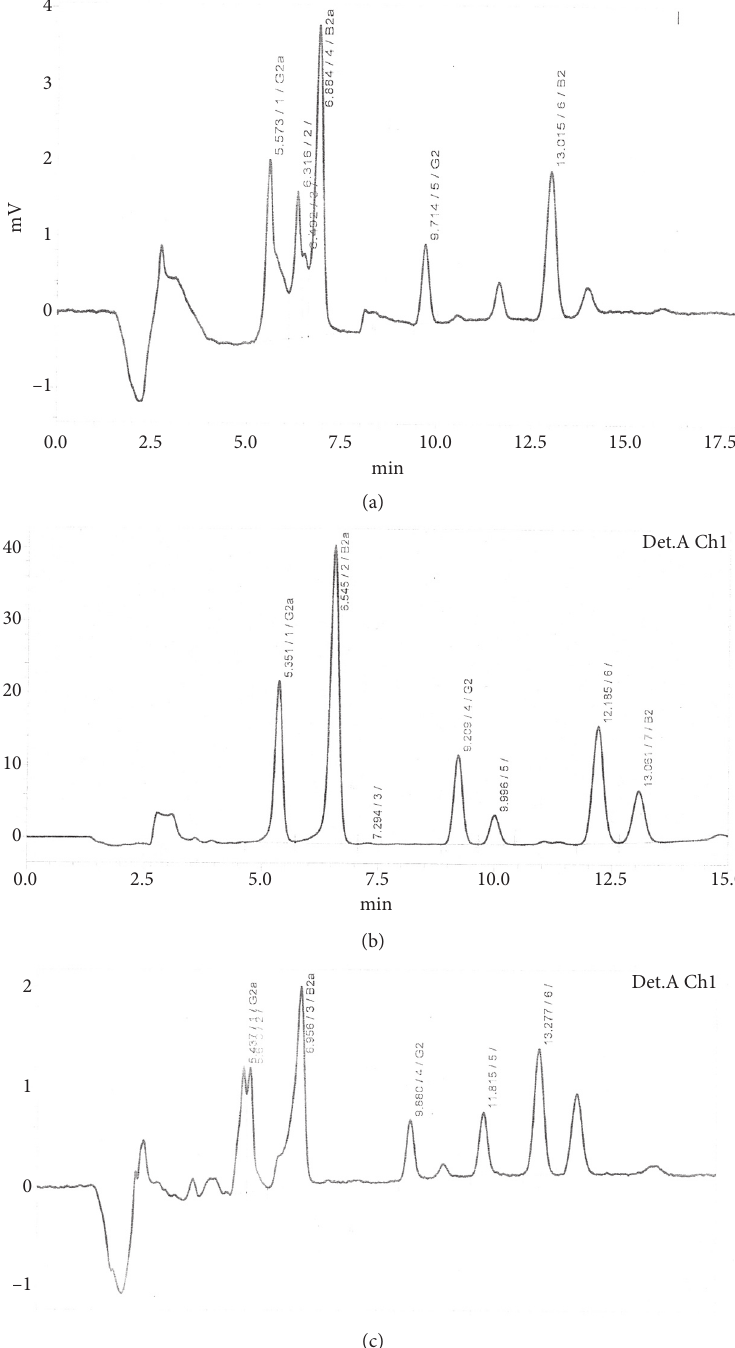
Figure 3: Reverse-phase HPLC characterization of hydrocolloid extracted from S. surattense (a), S. nigrum (b), and S. indicum